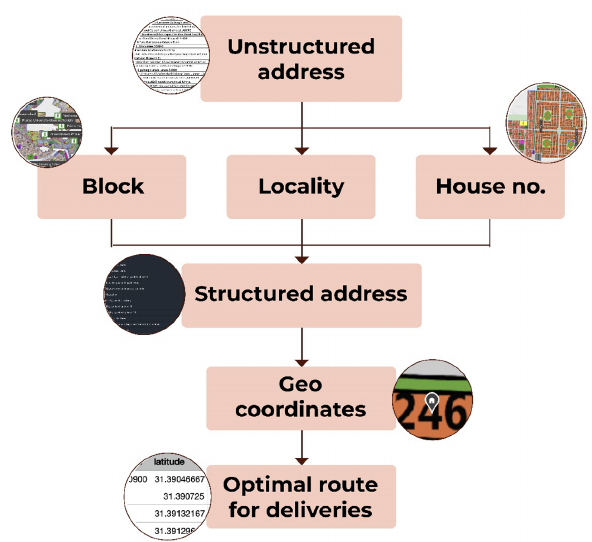
Figure 1. Representation of end to end pipeline for optimized route planning